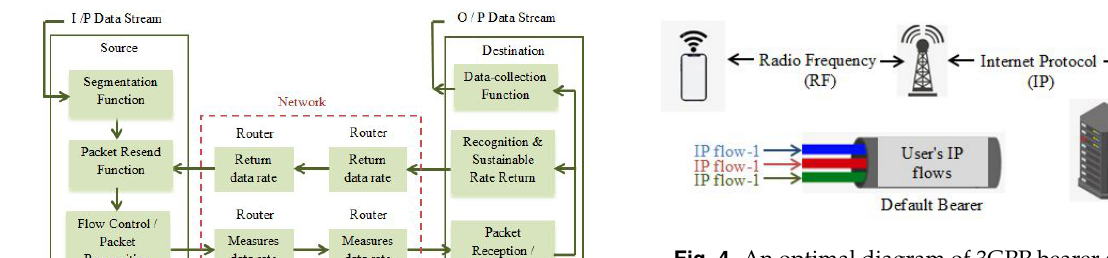
Fig. 4. An optimal diagram of 3GPP bearer architecture